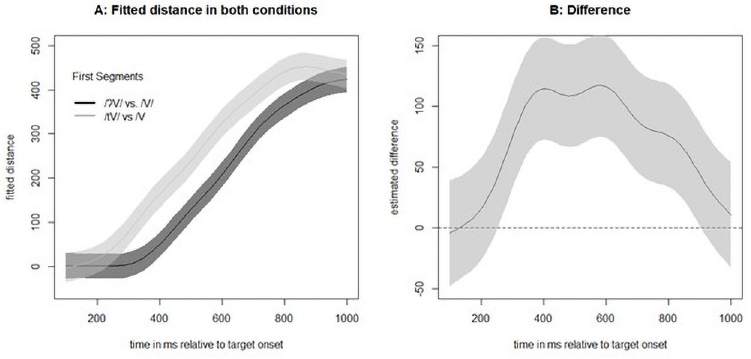
Fig 10. Outcome of the general additive model for target preference comparing vowel-initial words with stop- initial words (/t/-initial or / ʔ /-initial).